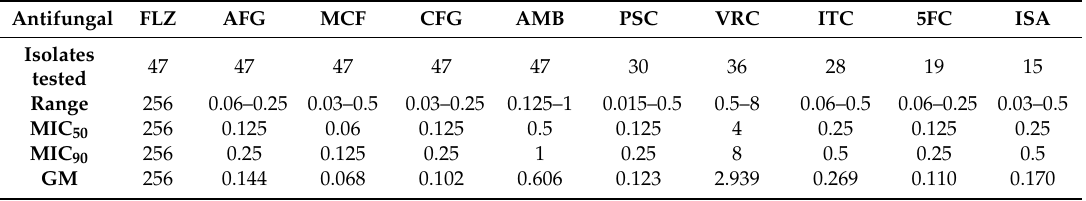
Table 2. Antifungal susceptibility of C. auris isolates from blood